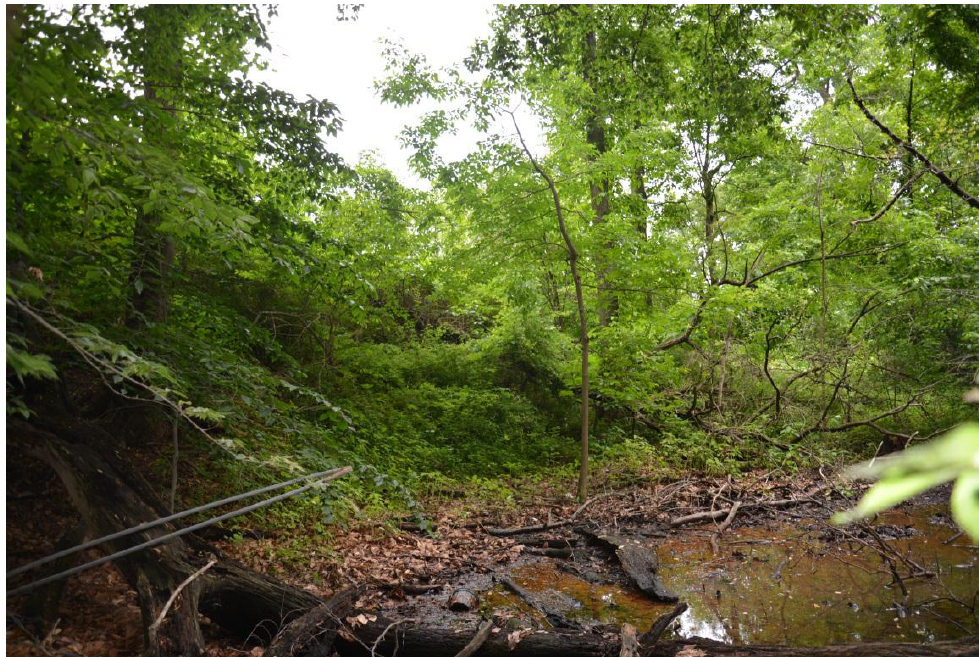
Figure 9. Photograph of inland area #3 (Figures 3 and 4). Photograph taken on 6 June